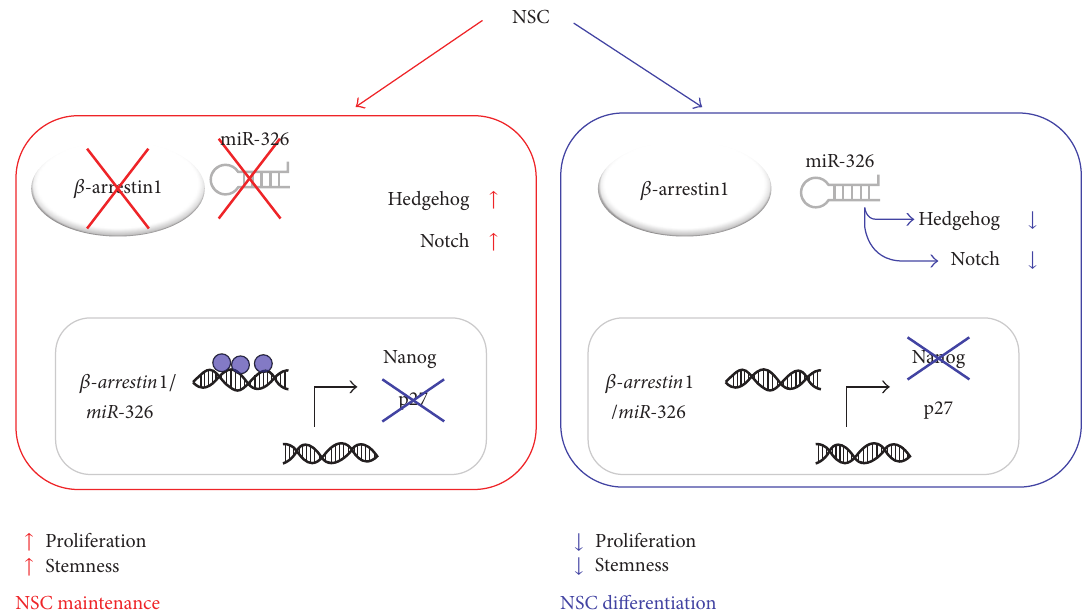
Figure 7: miR-326 and 𝛽 -arrestin1 are epigenetically silenced and control stemness features in cerebellar NSCs. We propose a model in which epigenetic silencing of the intragenic miR-326 and its host gene, 𝛽 -arrestin1, maintains physiological neuronal stemness. In cerebellar NSCs miR-326 and 𝛽 -arrestin1 are epigenetically silenced through hypermethylation of CpG islands on their common promoter, leading to a permissive molecular environment for the expression of prostemness and proproliferative cues. Upon differentiation or demethylating treatment, the promoter of the locus miR-326/ 𝛽 -arrestin1 is demethylated and thus the expression levels of miR-326 and 𝛽 -arrestin1 are upregulated. While miR-326 targets molecules belonging to the Hedgehog pathway and the Notch pathway, thus hampering stemness properties, 𝛽 -arrestin1 acts as a cofactor for the transcriptional activation of p27, leading to cell cycle arrest.